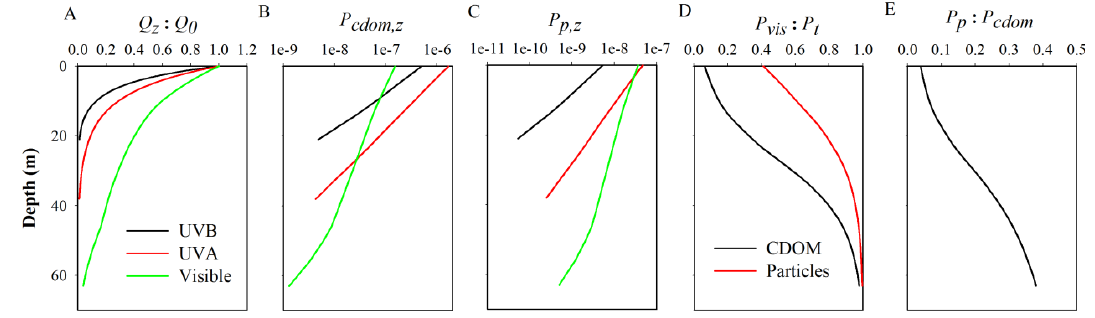
Fig. 6. Modeled vertical profiles of normalized solar irradiance (A) , CO photoproduction rate (molCOm − 3 h − 1 ) from CDOM (B) and particles (C) , the contribution of visible to full-spectrum CO photoproduction (D) , and the ratio of full-spectrum particle-based to CDOM- based CO photoproduction (E) at Sta. 430.